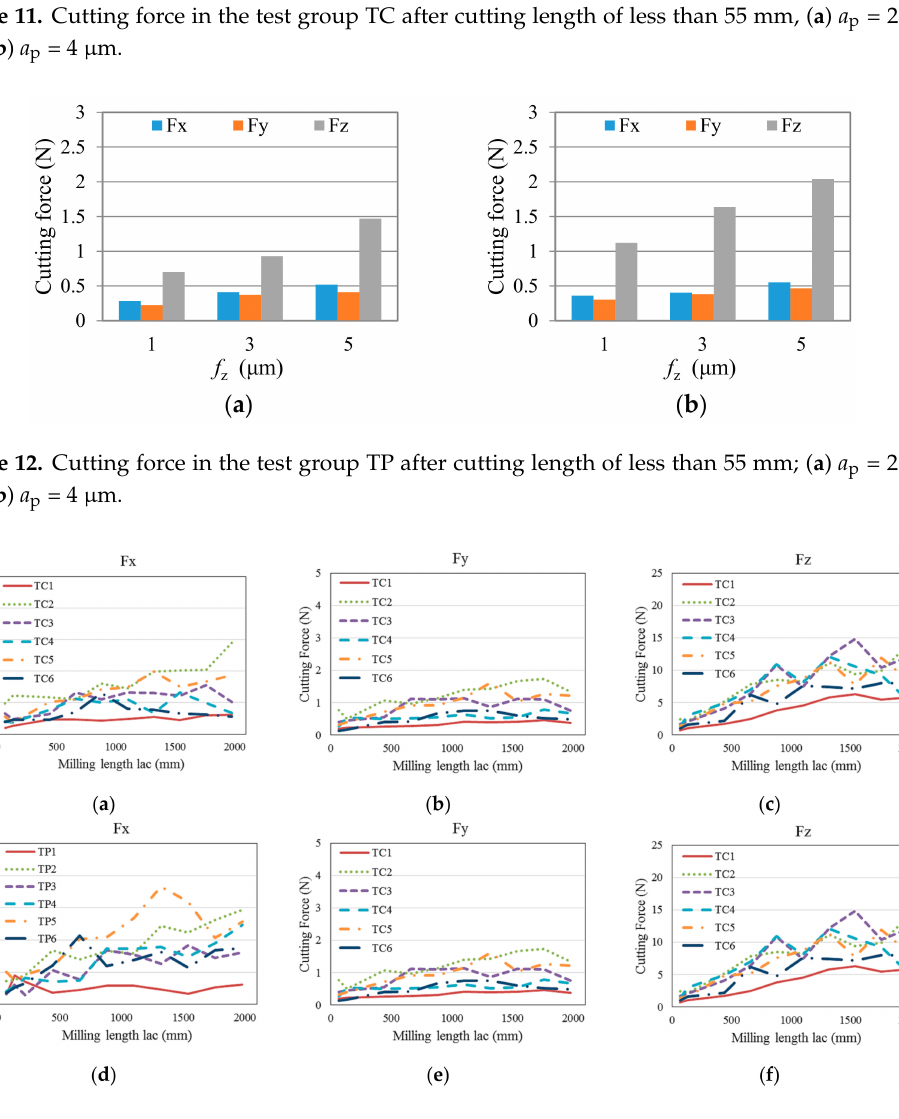
Figure 13. Cutting force in three directions changes with milling length: ( a ) TC— F x ; ( b ) TC— F y ; ( c ) TC— F z ; ( d ) TP— F x ; ( e ) TP— F y ; ( f ) TP— F z